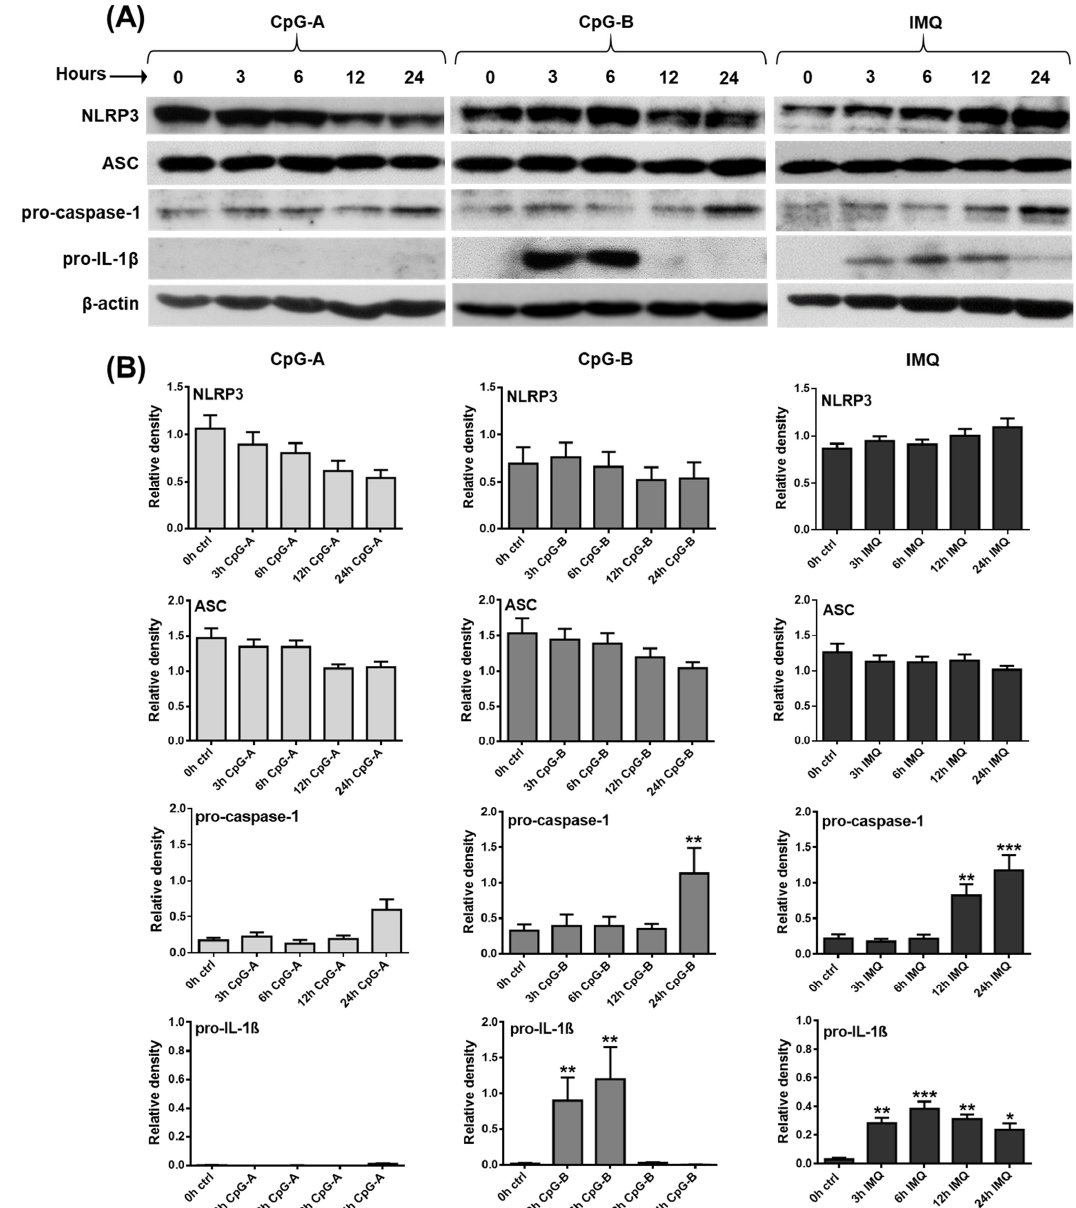
(data not shown). IL-1 β is only marginally expressed at the mRNA level (Supplementary Figure S1D) and while its pro-form is barely detectable at the protein level (Figure 1A,B), its cleaved form is undetectable in unstimulated pDCs (data not shown). Although low levels of IL-18 could be detected at the mRNA level in resting pDCs (Supplementary Figure S1E), its pro-form was not detectable at the protein level (data not shown). IL-1 α was not present either at the mRNA or protein level in non-activated pDCs (data not shown).